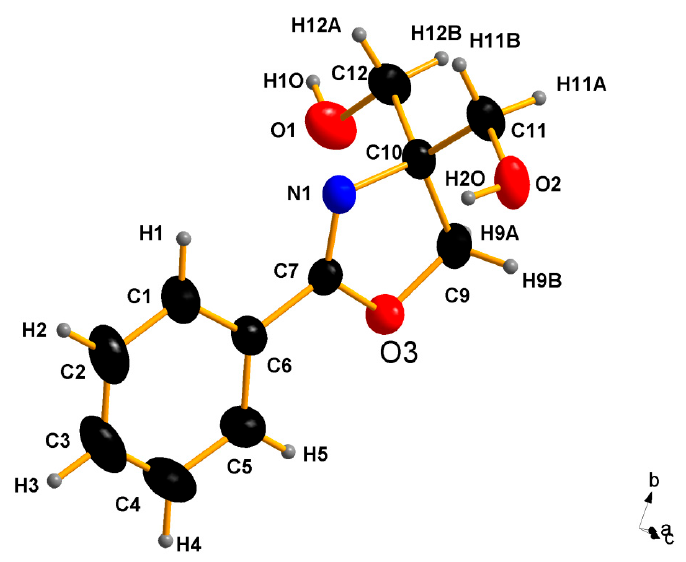
Figure 2. Asymmetric unit in the crystal structure of 4,4-bis(hydroxymethyl)-2-phenyl-2-oxazoline, ellipsoids drawn at 50%.